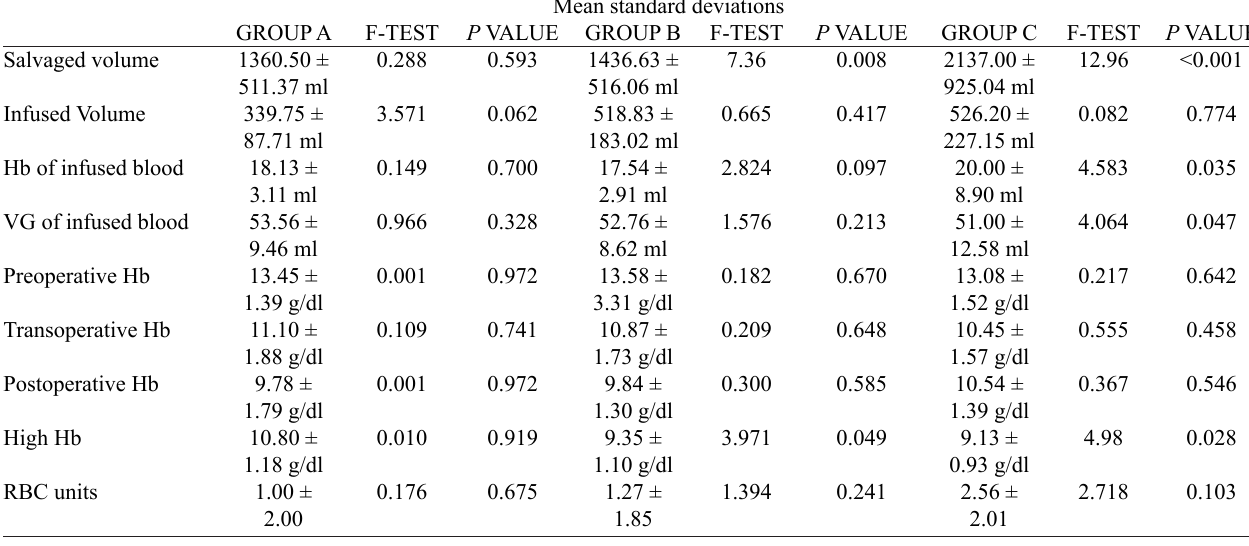
Table 2. Mean and standard deviation of the salvaged volume, infused volume, Hb infused blood, VG infused blood, preoperative Hb, trans- operative Hb, postoperative Hb, high Hb, RBC